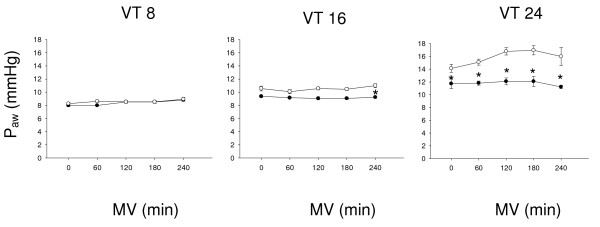
Mean airway pressures (Paw) in young (black circles) versus old (white circles) mechanically ventilated rats. Mechanical ventilation (MV) was applied with tidal volume (VT) of 8, 16 or 24 ml/kg body weight, respectively. * = P <0.05 old vs. young animals; #, § = P <0.05 time point vs. start of MV.